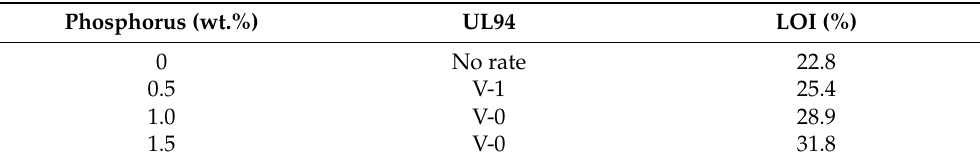
Table 3. Flame retardant properties of different resin